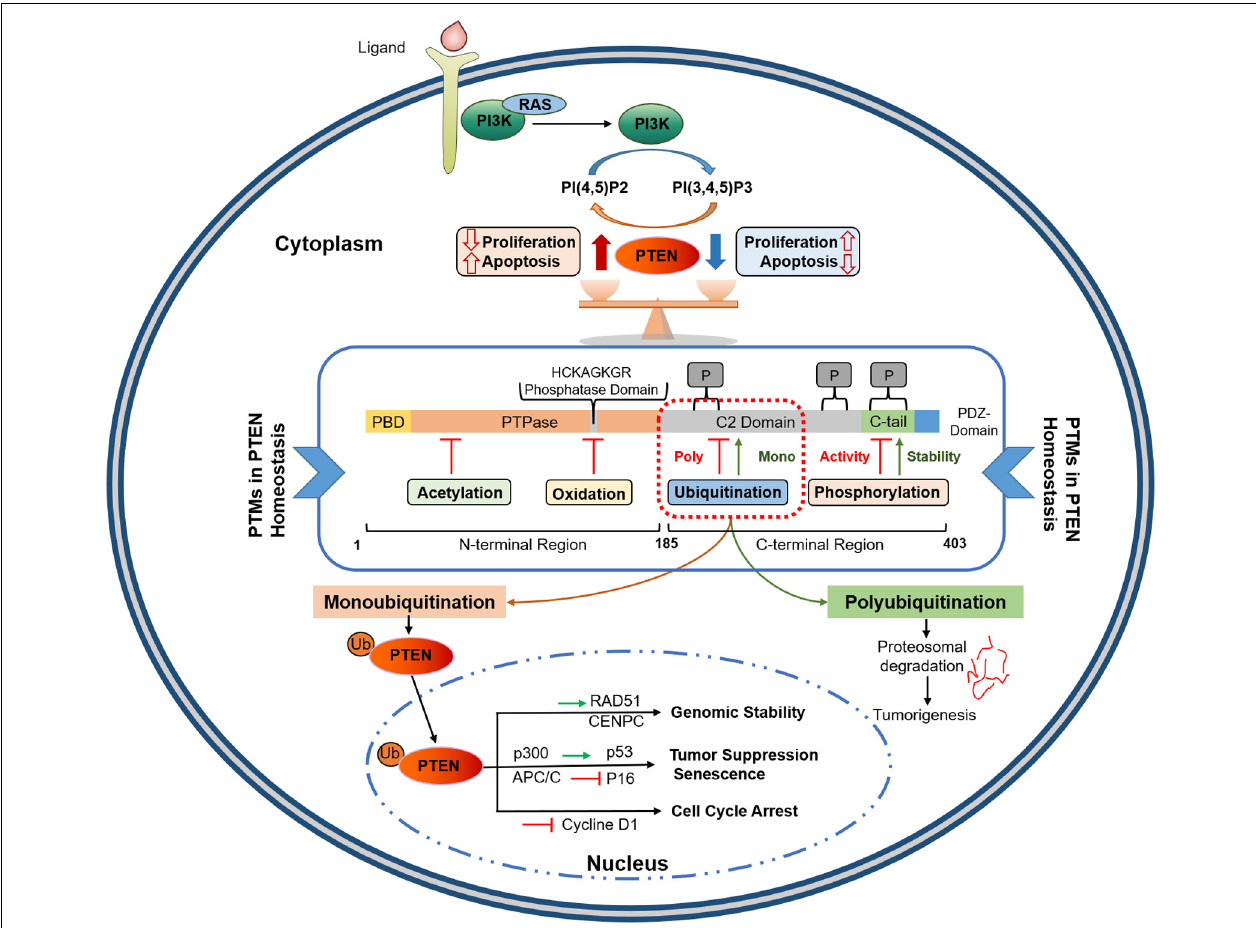
FIGURE 1 | PTEN protein structure and its functional regulation by post-translational modifications. PTEN comprises 403 amino acids with five functional domains, including a PIP2-binding domain (PBD), a phosphatase domain having catalytic core, a C2 domain containing ubiquitination sites, two PEST domains for degradation, and a protein-protein interaction PDZ motif. Homeostatic balance of PTEN protein in cytoplasm regulates health proliferation and apoptosis in the cell. PTEN post-translational regulation involves ubiquitination within the PBD and C2 domains, oxidation and SUMOylation in the C2 domain, acetylation on PTPase and PDZ-binding sites, while phosphorylation occurs within the C2 domain and C-tail terminal. Polyubiquitination marks PTEN for Proteosomal degradation while Monoubiquitination transport it to nucleus. Nuclear PTEN performs several important functions, including genomic stability regulation via interacting with CENPC and RAD51, apoptosis induction by upregulating p53, and cell cycle arrest and senescence by inhibiting Cycline D1 and p16, respectively. PIP2, Phosphatidylinositol-4,5-bisphosphate; PEST, proline, glutamic acid, serine, threonine; PTPase, protein tyrosine phosphatase; PBD, PIP2-binding domain; APC/C, anaphase-promoting complex; CENPC, centromere protein